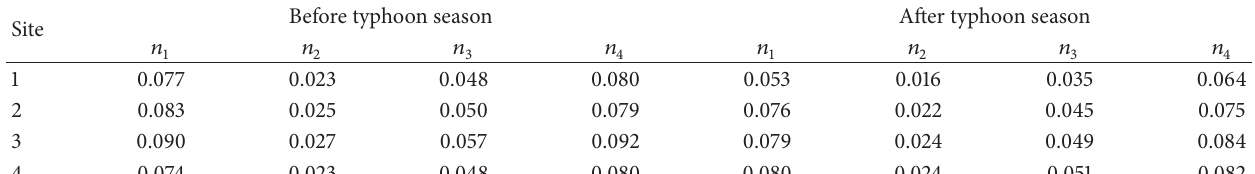
Table 3: Manning’s roughness coefficient computed from empirical formulas.